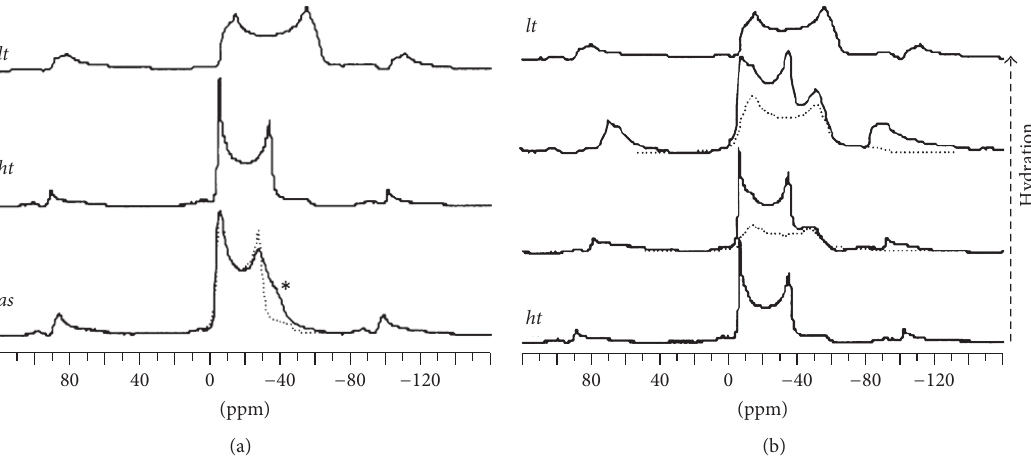
Figure 2: 27 Al SSNMR spectra of MIL-53 (Al) in (a) different phases and (b) different hydration content. Reprinted with permission from Ref. [8]. Copyright 2004 John Wiley and Sons. The dot line represents the simulated 27 Al NMR line shape and ∗ refers to residual Al(OH) 3 .